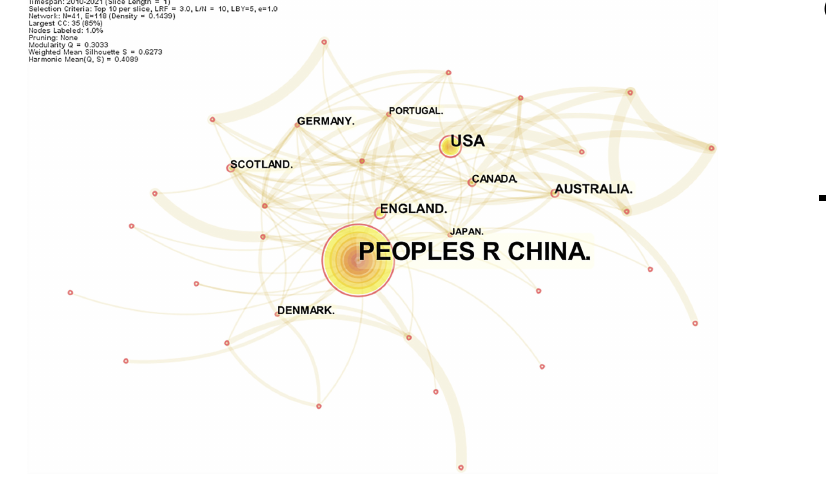
Figure 3. National (regional) cooperation network